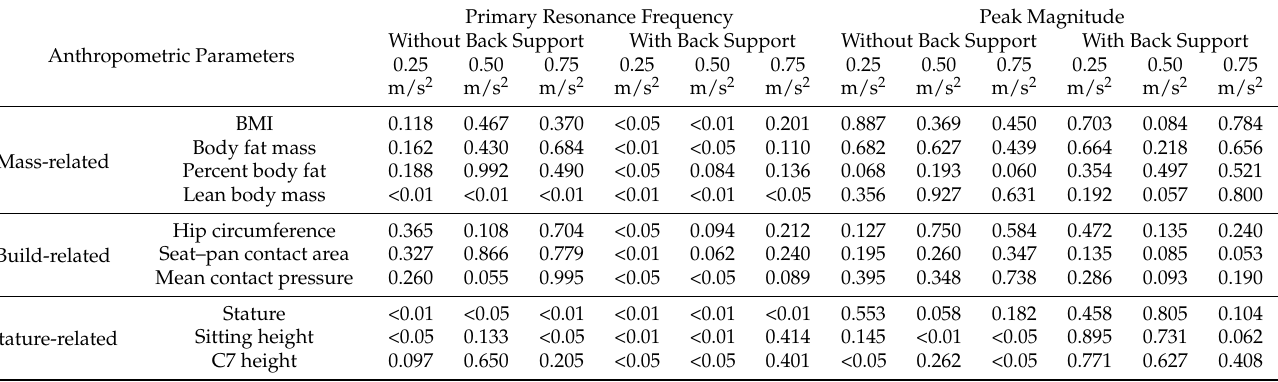
Table 7. p -values obtained from independent t -tests of peak vertical STHT magnitude and primary resonance frequency between the male and female subjects of comparable anthropometric dimensions for the two back support conditions and three excitation